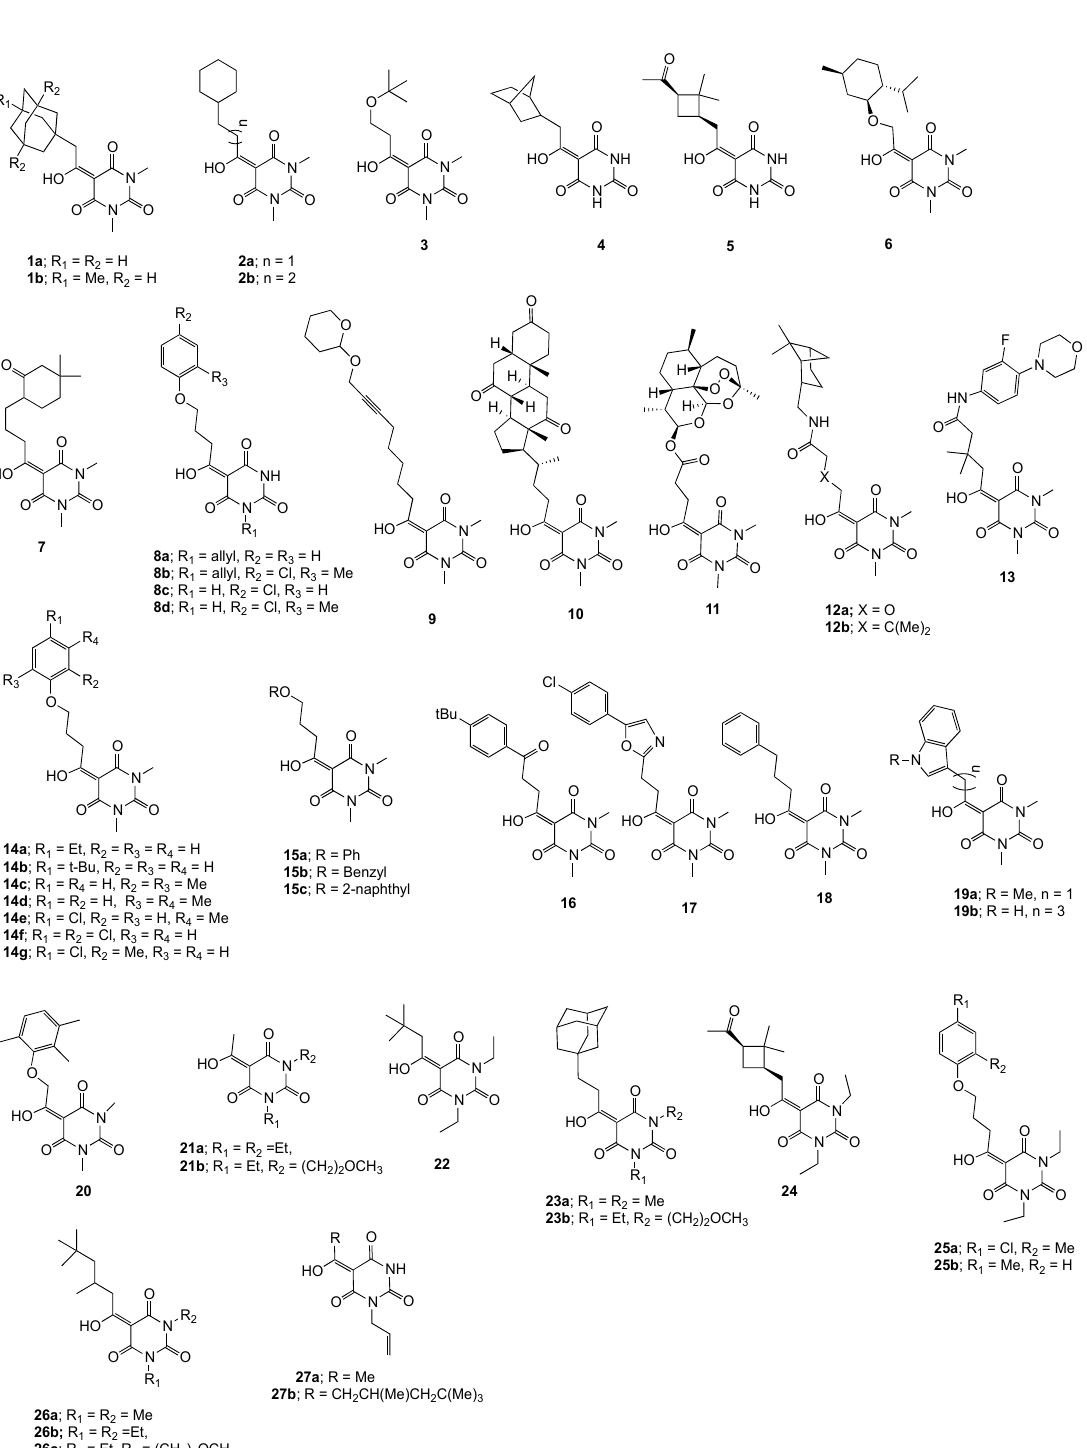
Figure 1. Chemical structures of 3-acylbarbituric acids analogues.